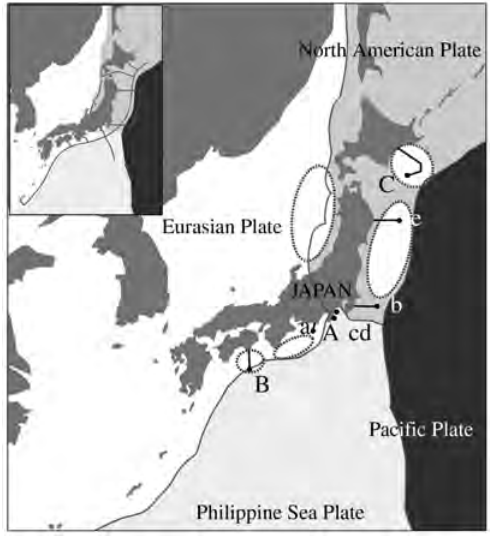
Fig. 7. Map of the cable-connected ocean bottom observatories in Japan (Shirasaki et al. , 2003): a) JMA – Omaezaki; b) JMA – Off-Boso; c) ERI – Off- Ito City; d) ERI – Off-Sanriku; e) NIED – Hiratsuka; A) JAMSTEC – Off-Hatsushima; B) JAMSTEC – Off-Muroto Peninsula; C) JAMSTEC – Off-Kushiro- Tokachi. A map of the planned ARENA cable is shown in the top-left